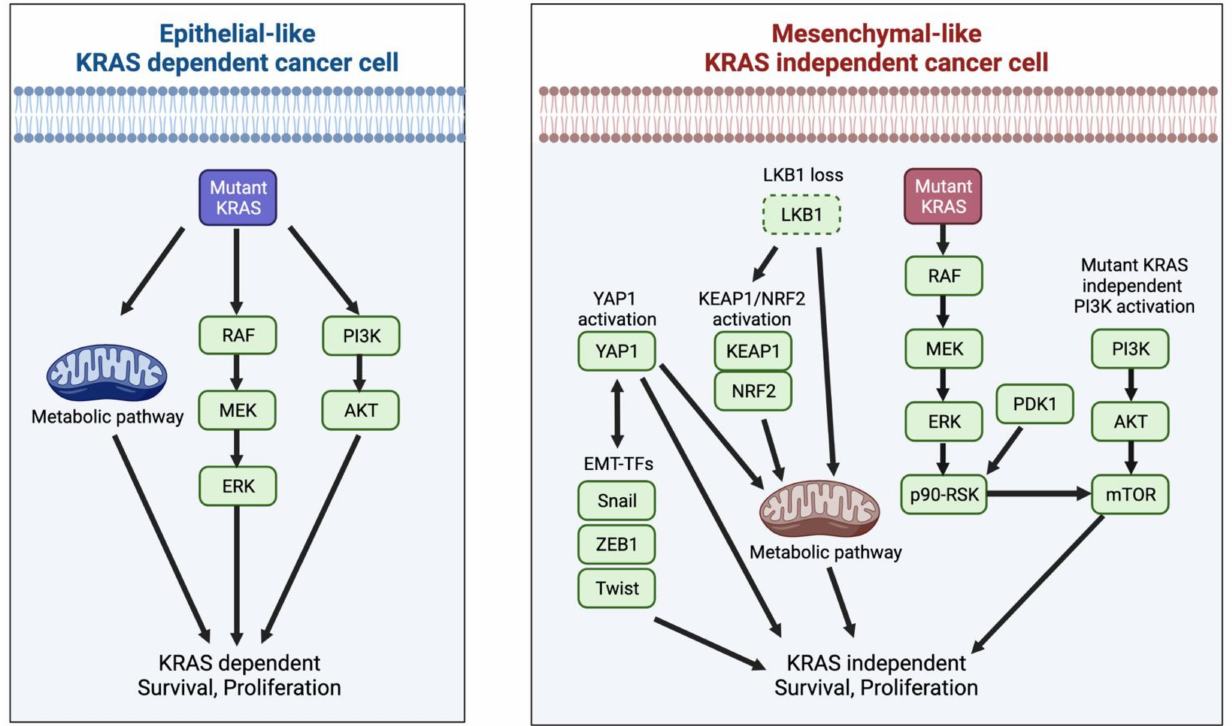
Figure 1. Heterogeneity of KRAS mutant cancer characterized by EMT and KRAS dependency. The role of mutant KRAS in proliferation and survival is variable in tumor cells driven by KRAS mutations. While KRAS-dependent cancer cells show an epithelial-like phenotype, KRAS is dispensable for the survival of mesenchymal-like KRAS mutant cancer cells. KRAS mutant cancer cells acquire mutant KRAS independency by various means: activation of RSK-mTOR pathway and/or KEAP1-NRF2 pathway, YAP activation, LKB1 loss, and mutant KRAS-independent PI3K activation. These bypass signaling pathways are involved in activation of survival signaling pathways, rewiring of metabolic pathways, and induction of EMT. EMT transcription factors also promote KRAS independency. The activated bypass signaling networks and EMT are interdependent. Abbreviations: EMT, Epithelial-to-mesenchymal transition; EMT-TFs, Epithelial-to-mesenchymal transition transcription factors; KEAP1, Kelch-like ECH-associated protein 1; KRAS, v-Ki-ras2 Kirsten rat sarcoma viral oncogene homolog; LKB1, liver kinase B1; mTOR, mammalian target of rapamycin; NRF2, Nuclear factor erythroid 2-related factor 2; PI3K, Phosphatidylinositol 3-Kinase; RSK, Ribosomal S6 kinase; YAP, Yes-associated Protein